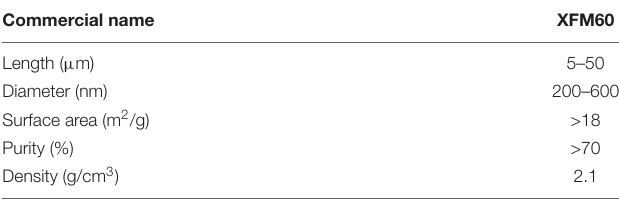
TABLE 2 | Properties of carbon nanofibers (CNFs).